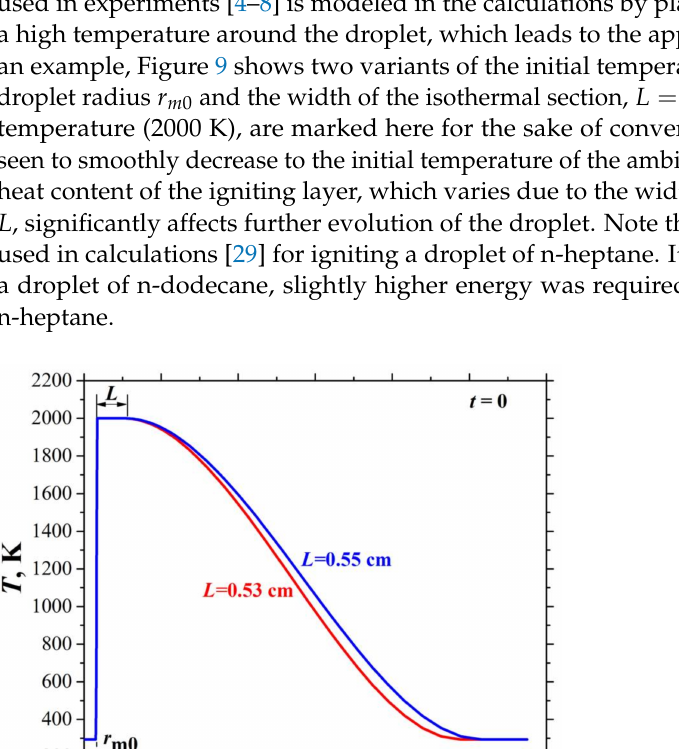
Figure 8. Calculated and measured time histories of the D 2 / D 2 n-dodecane droplet with D 0 ≈ 4.3 mm in the synthetic air with X O2 = 0.21 and X N2 = 0.79 at NPT conditions.